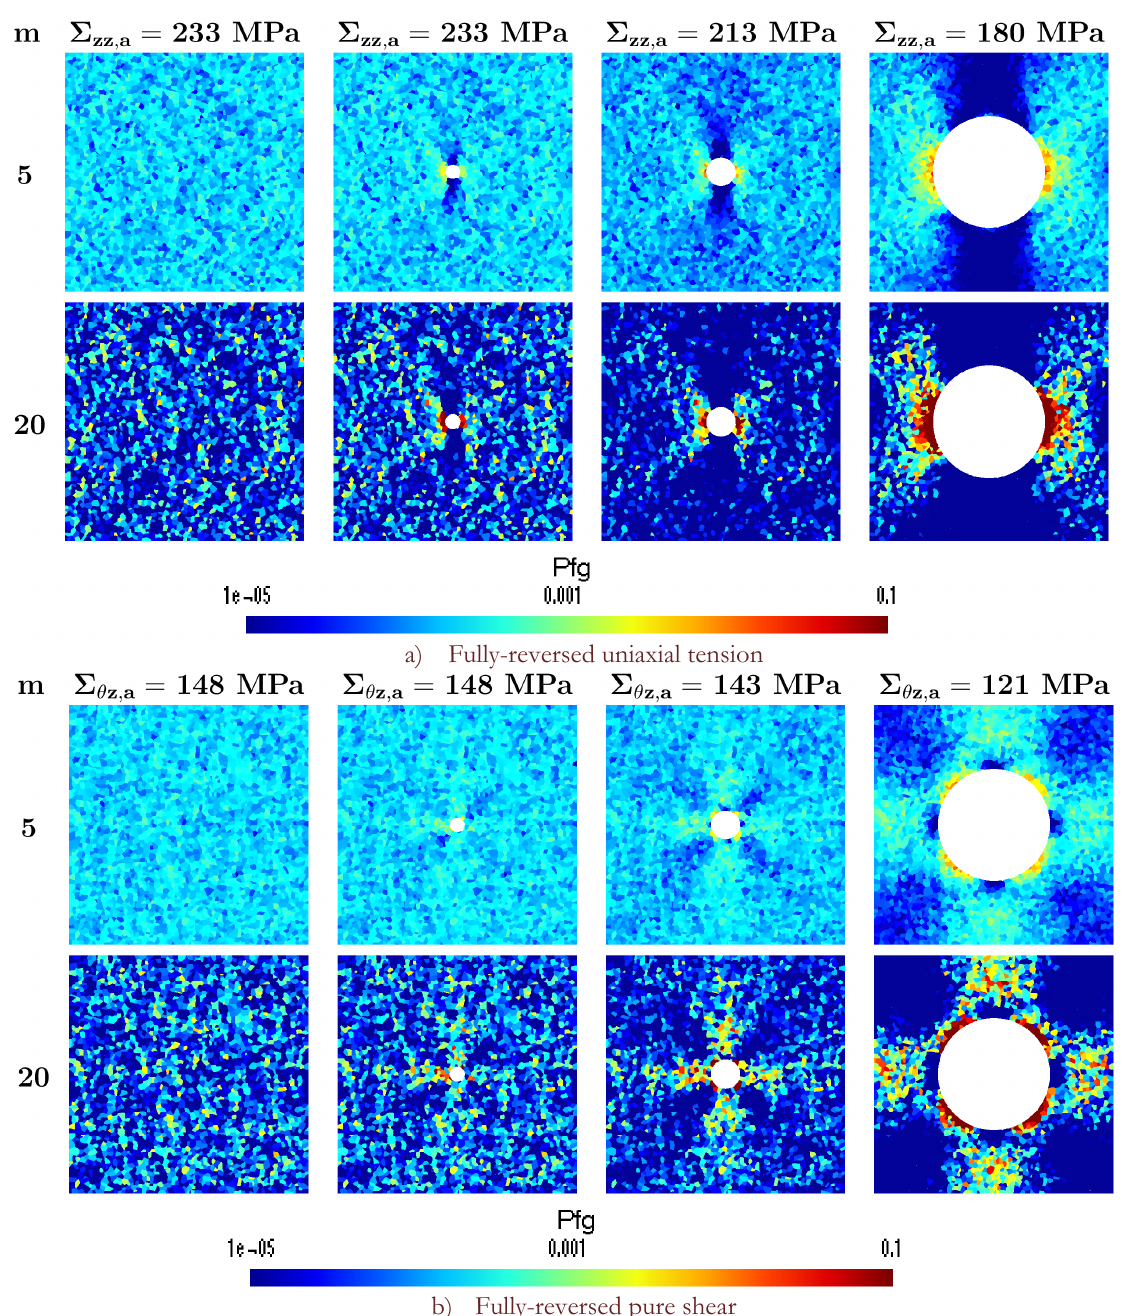
Figure 4: Distributions of the failure probability per grain for a synthetic microstructure of 316L steel loaded in a) fully-reversed uniaxial tension and b) fully-reversed pure shear at the experimental average fatigue limit level. Effect of the defect diameter D (from 0 to 365  m) and the shape parameter m (5 or